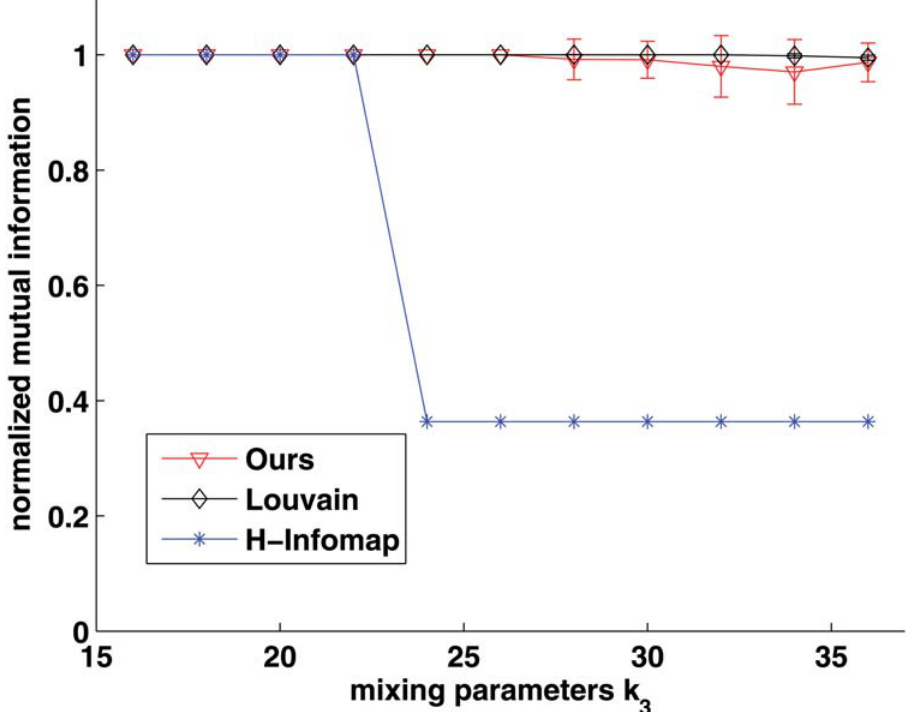
Fig 5. Comparison with Louvain method and H-Infomap on hierarchical community benchmarks at its first level. X-axis indicates the mixing parameter, and the Y-axis indicates the normalized mutual